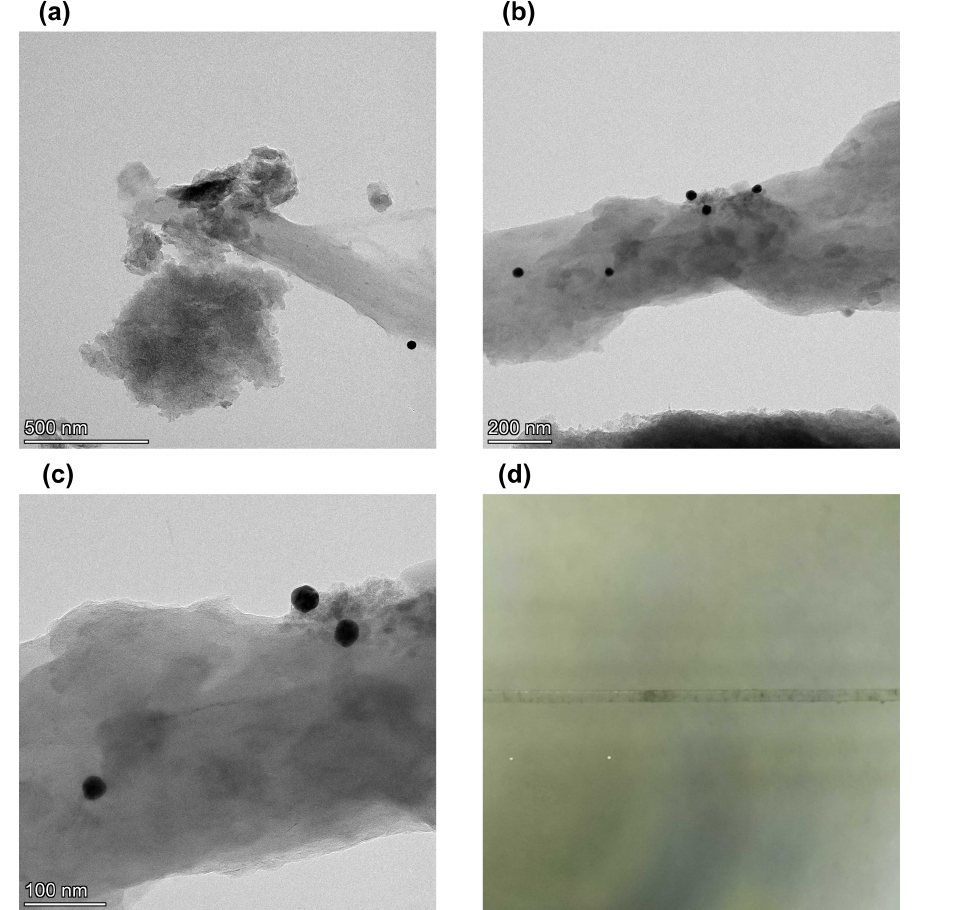
Figure 3. Transmission electron microscopy images of ( a ) graphene from shungite particles with gold nanoparticles with gold to graphene ratio 1:1, ( b ) graphene form shungite particles with gold nanoparticles with 3:1 ratio of gold to graphene and ( c ) zoomed image of graphene form shungite particles with gold nanoparticles with ratio of gold to graphene 3:1, ( d ) photo of microfiber with graphene and gold nanoparticles deposited on the